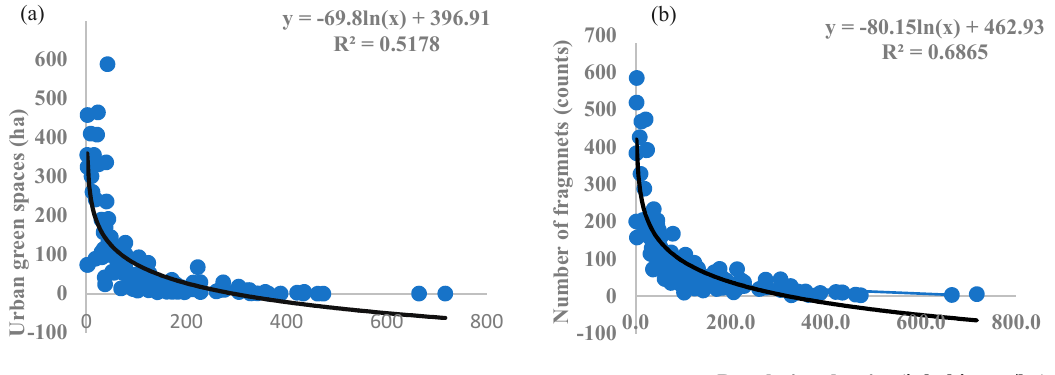
Figure 4. Correlations among urban green spaces, urban green space fragments, and population density in Addis Ababa: ( a ) correlation between urban green spaces and population density; ( b ) correlation between number of fragments and population density.